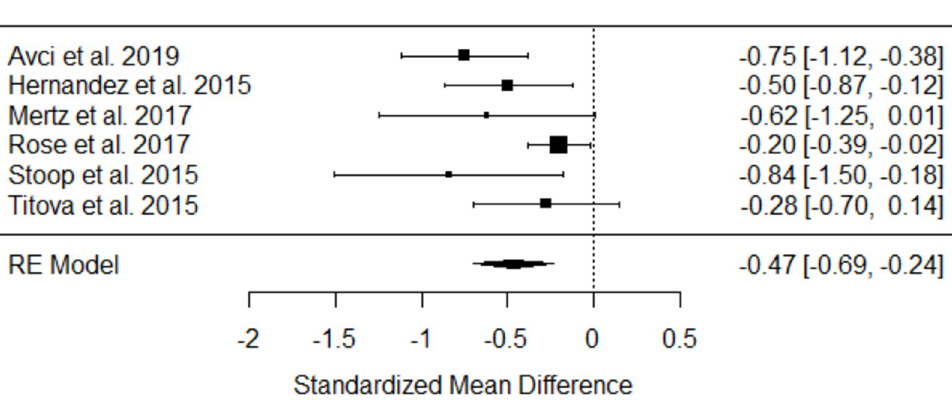
Fig 2. Forest plot on the effect of case management interventions on feelings of anxiety (random-effects